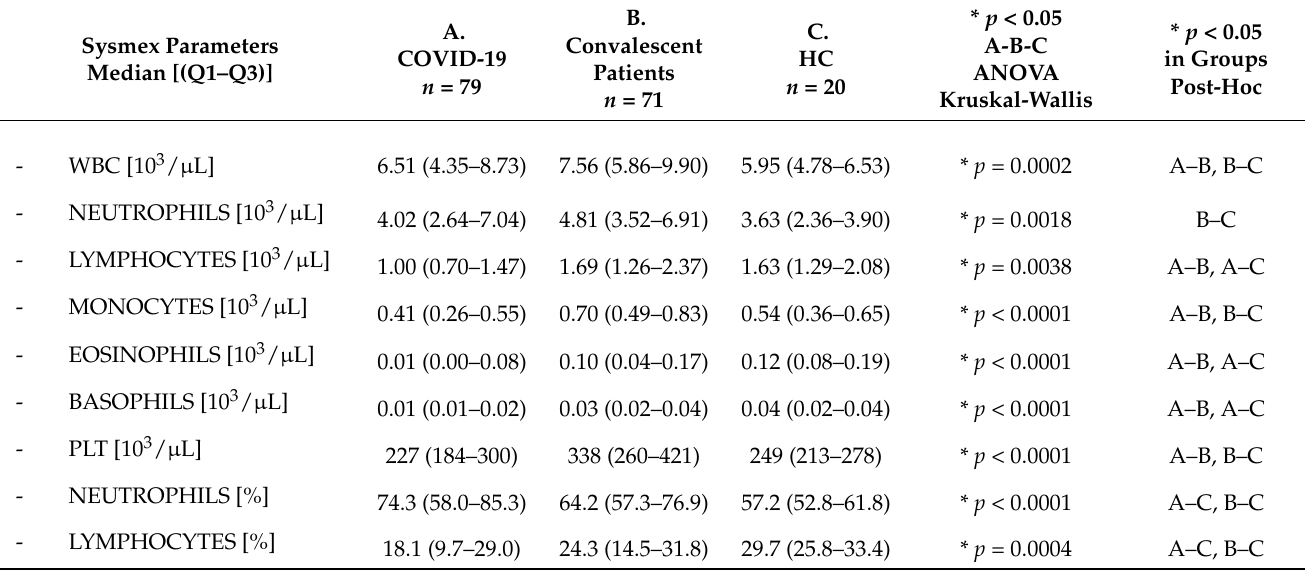
Table 3. Proportion of Sysmex morphological parameters in patients: with COVID-19 (A), convalescent patients (B), and control group (HC) (C). Data expressed as median (Q1–Q3). * indicates p statistically